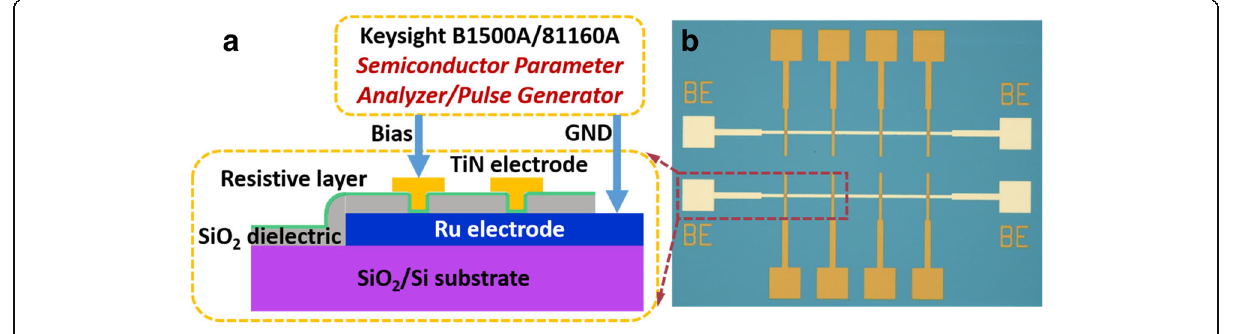
Fig. 1 a Schematic diagram of a Ru-based device. b Fabricated RRAM array